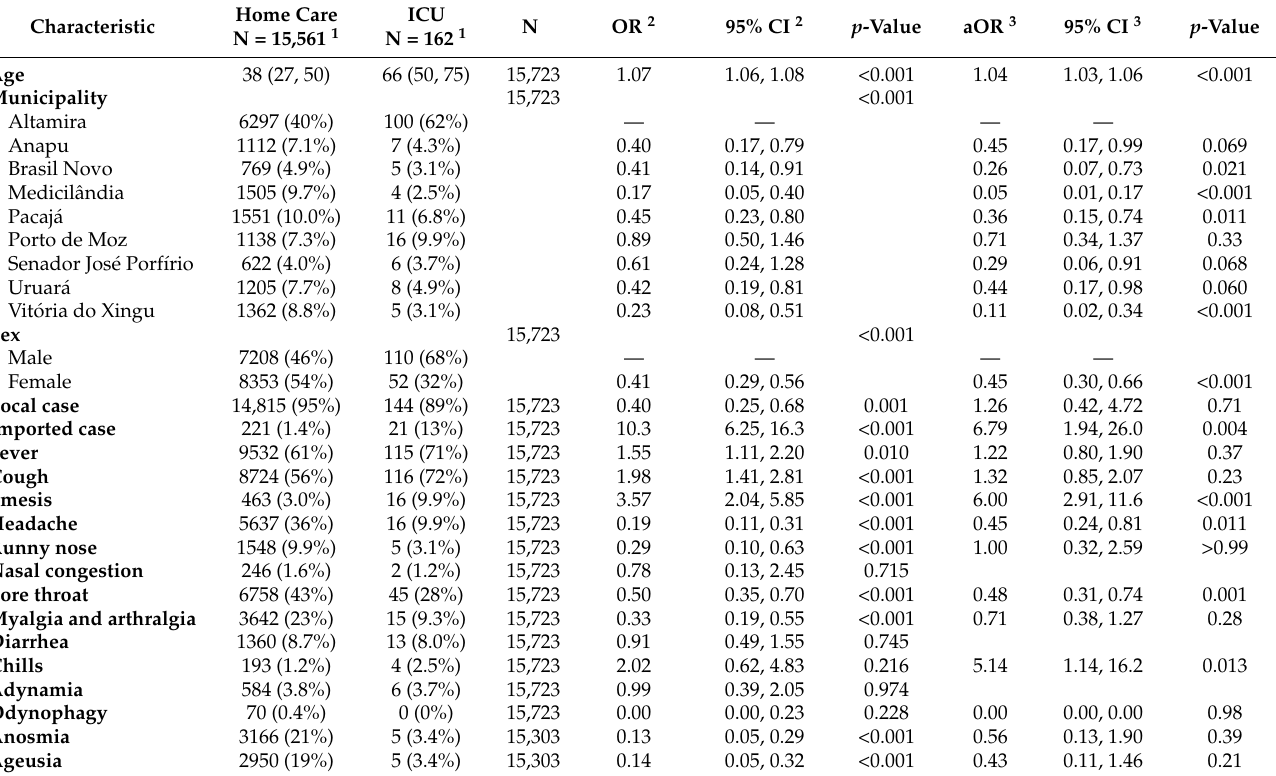
Table 3. Sociodemographic factors, symptoms, and comorbidities as predictors of admission to intensive care units (ICU) compared with home